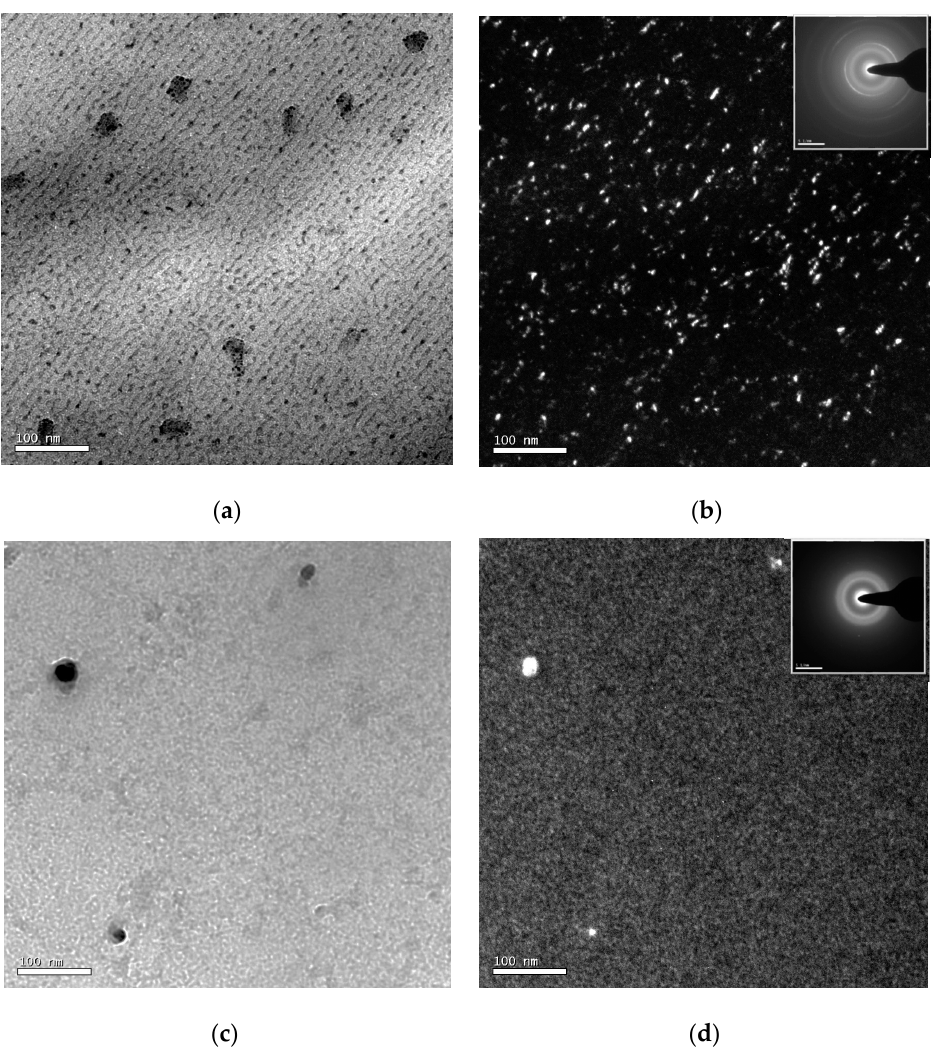
Figure 7. TEM bright field and dark field images of Cu 47 Zr 43 Al 7 Ag 3 ( a , b ) and Cu 47 Zr 43 Al 7 Ag 6 ( c , d ) BMG alloys.